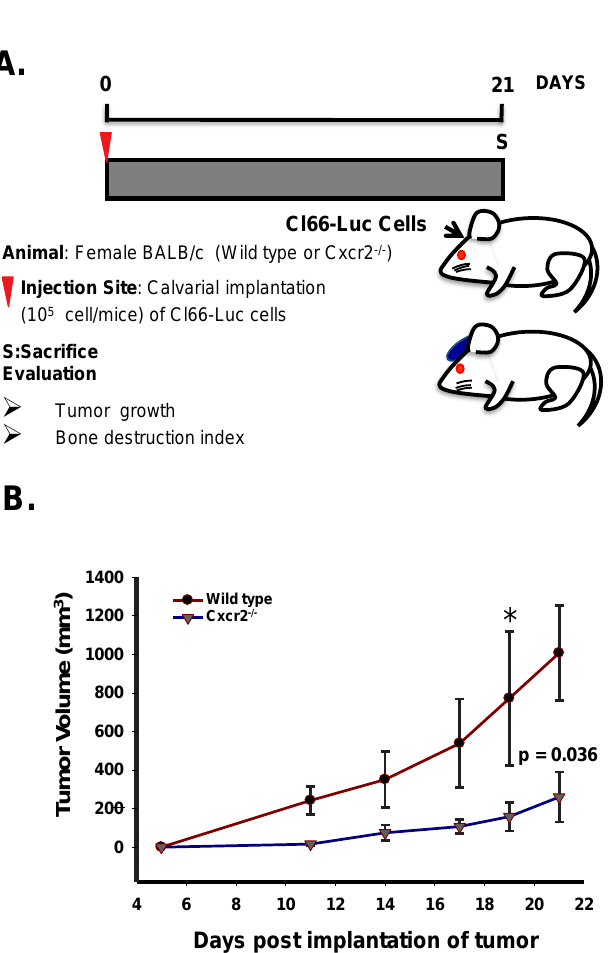
Figure 4. Host CXCR2 promotes tumor cell growth in the bone microenvironment. ( A ) Schematic diagram of the Cl66-Luc cell injection in calvaria of wild type and Cxcr2 − / − mice. ( B ) The graph shows the kinetics of tumor volume formed by Cl66-Luc cells in the bone microenvironment of the wild type and CXCR2 − / − mice. Statistical analysis was done using the Mann-Whitney Rank Sum Test with * p = 0.036 and n =